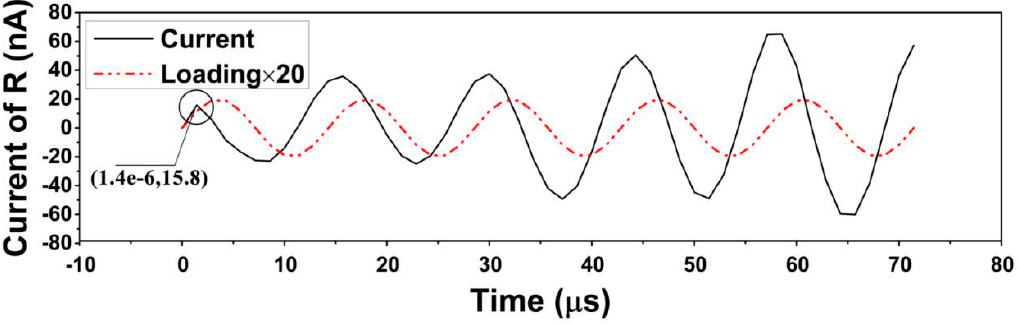
Figure 14. Loading-current response diagram (of 70,000 Hz). The loading is multiplied by 20 to make it easier to observe. (Current of R shows the current of the resistance).